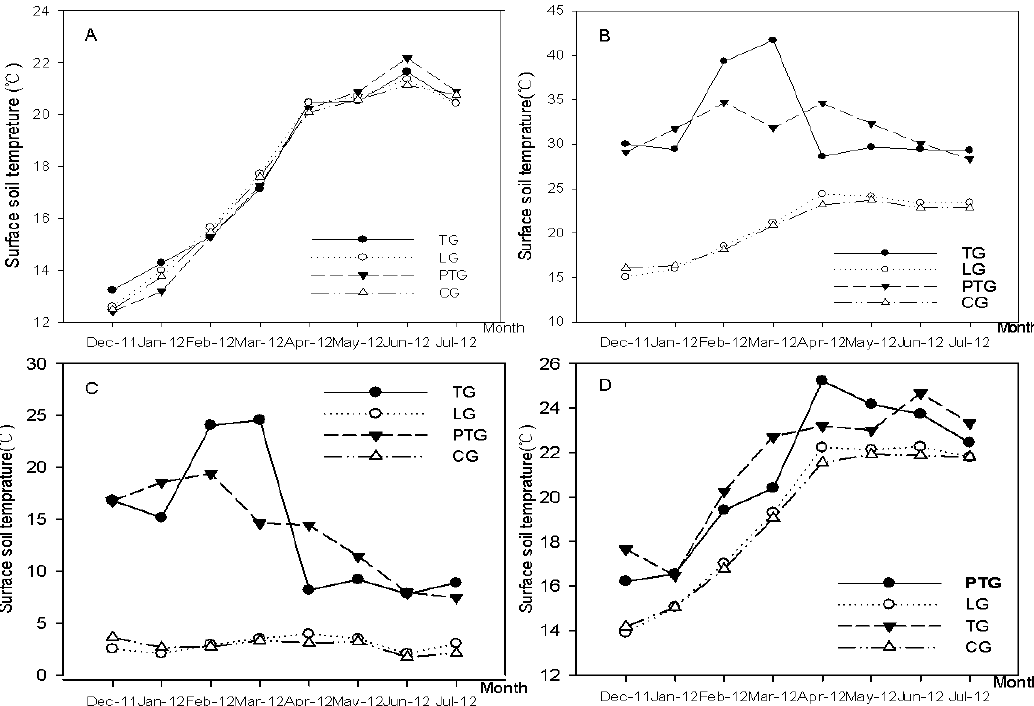
Figure 4. Temperature characteristics of the soil seed bank micro-environmentunder different photo- thermal treatments: ( A ) monthly average minimum daily soil surface temperature; ( B ) monthly average maximum daily soil surface temperature; ( C ) monthly average daily variation of the soil surface temperature; ( D ) monthly average soil surface temperature. Dec is December, Jan is January, Feb is February, Mar is March, Apr is April, Jun is June, and Jul is